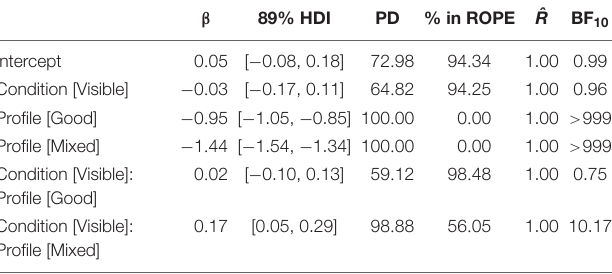
TABLE 1 | Summary of the model fitted to the rent data, considering the experimental condition (Visible or Reveal) and Profile type (Good, Mixed, and Bad).